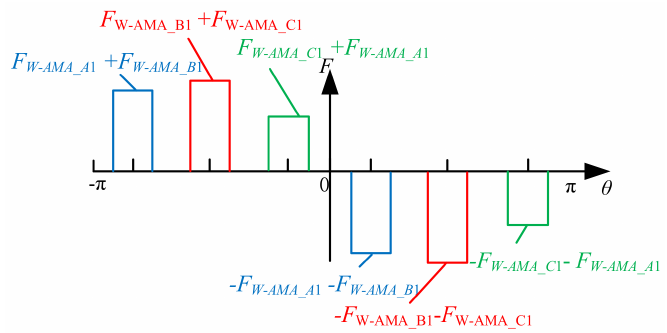
Figure 11. Armature reaction MMF model for AMA-FRPM machine.